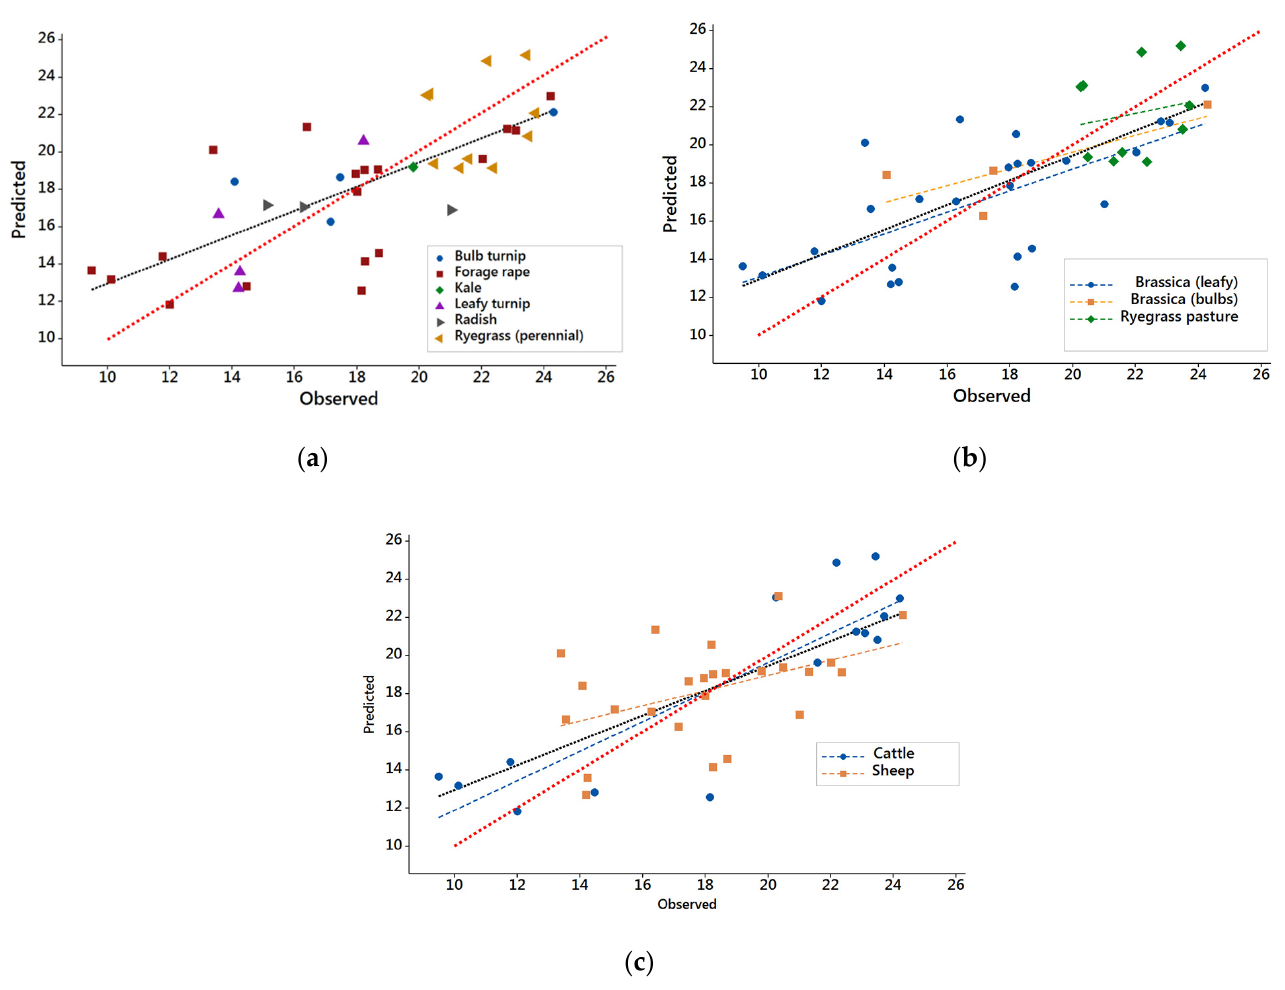
Figure 1. Scatterplots of the observed methane yields and methane yields predicted from near-infrared reflectance spectra for samples in database DB1 [all experiments with a common feeding level of 1.6× metabolizable energy (ME) maintenance requirements]. The red dotted line in all plots is the line predicted = observed. The black dotted line in all plots represents the regression predicted = 6.45 + 0.649 (observed); adjusted R 2 = 0.53; both the intercept and slope are significantly different from zero: p < 0.001. ( a ) Scatterplot of all samples in database DB1. ( b ) Scatterplot according to feed type, for samples in database DB1. The blue, orange and green dotted lines represent the regression lines for leafy brassicas, brassica bulbs and ryegrass pasture, respectively. Only leafy brassicas had regression parameters significantly different from zero: p < 0.001. ( c ) Scatterplot according to animal species, for samples in database DB1. The blue line and dark red dotted lines represent the regression lines for cattle and sheep, respectively. Both regression lines are significant p < 0.01.